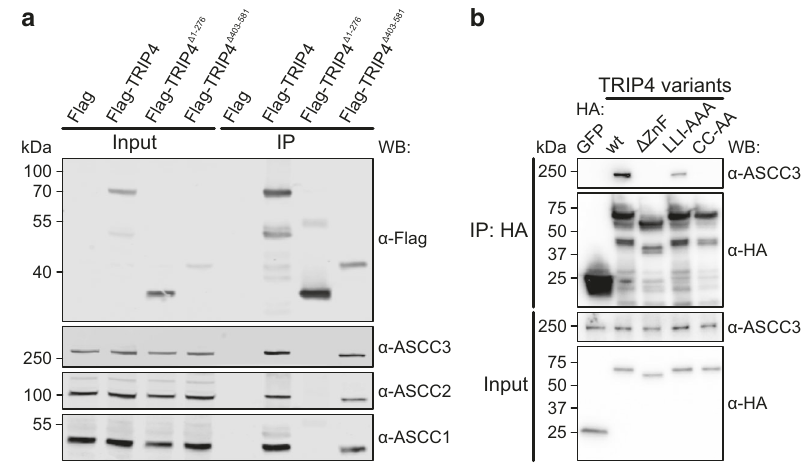
Fig. 2 | Interactions of TRIP4 variants in cells. a Western blots (WB) monitoring immunoprecipitation (IP) of ASCC1, ASCC2, and ASCC3 by the indicated N-terminally Flag-tagged TRIP4 variants from the cell extracts. b Western blots (WB) monitoring immunoprecipitation (IP) of ASCC3 by the indicated HA-tagged